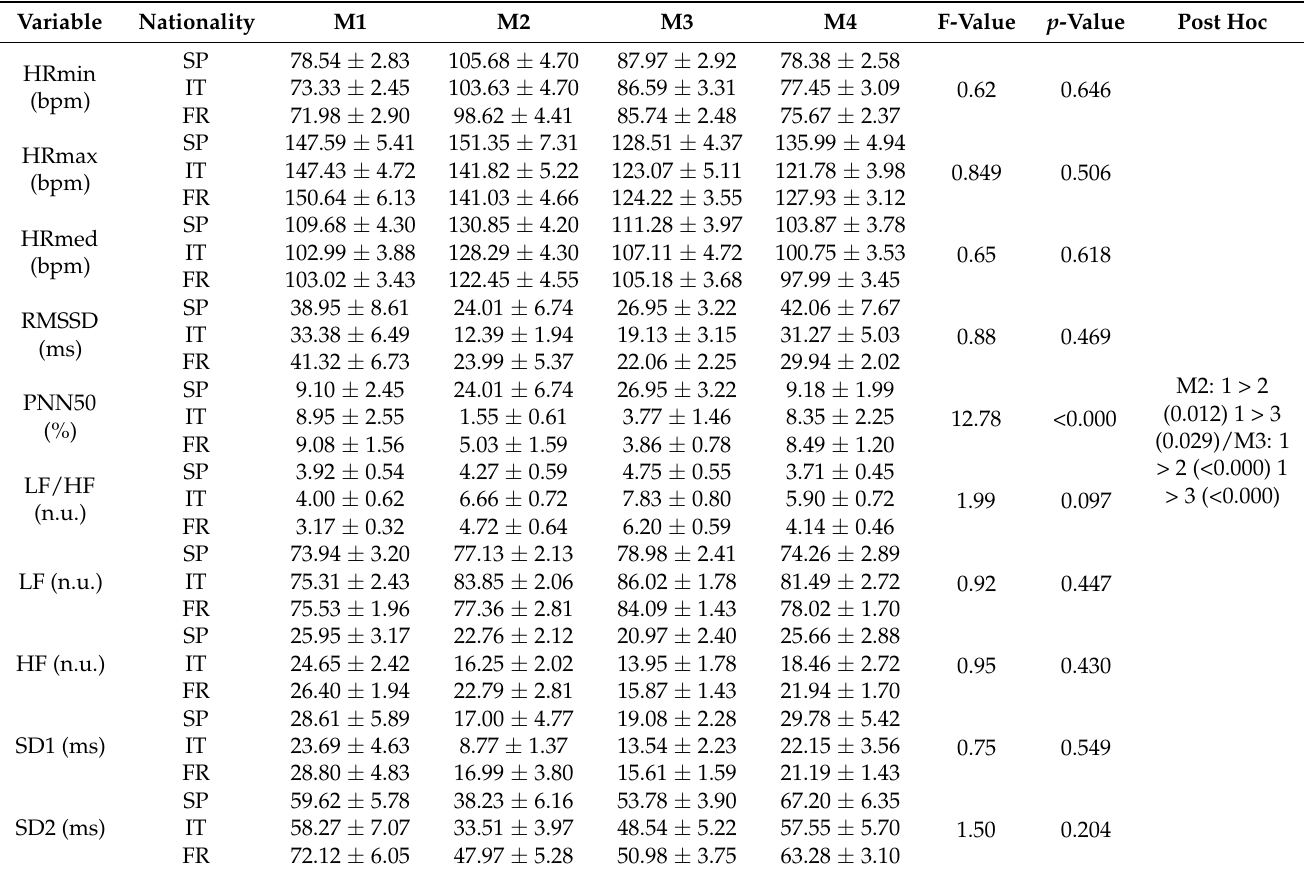
Table 1. Changes (Mean ± SD) in the autonomic stress response in the final thesis defense according to different nationality.